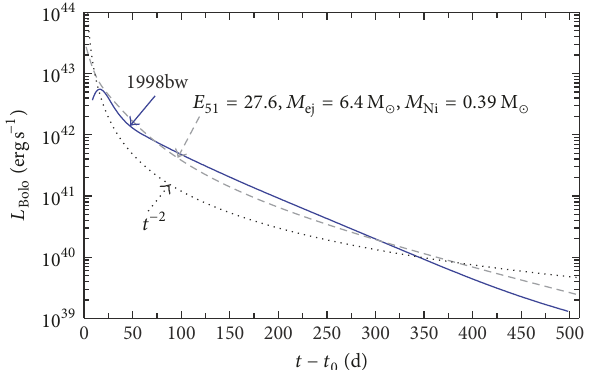
Figure 10: Late-time bolometric LC of SN 1998bw in filters 𝐵𝑉𝑅𝐼 . Two analytical models have been plotted to match the peak lumi- nosity: (1) a single-zone analytical model for a fiducial SN that is = 27.6 × 10 51 erg, an powered by radioactive heating, where 𝐸 K = 6.4 M 𝑀 = 0.39 M ejecta mass of 𝑀 ⊙ , and a nickel mass of ⊙ , ej Ni and (2) a 𝑡 −2 curve, which is the expected decay rate for luminosity powered by a magnetar central engine. At late times the decay rate of model (1) providesamuchbetterfitthanthe 𝑡 −2 decay,whichgrossly overpredicts the bolometric luminosity at times later than 400 d. ThisisonelineofobservationalevidencethatGRB-SNearepowered by radioactive heating and not via dipole-extracted radiation from a magnetar central engine (i.e., a magnetar-driven